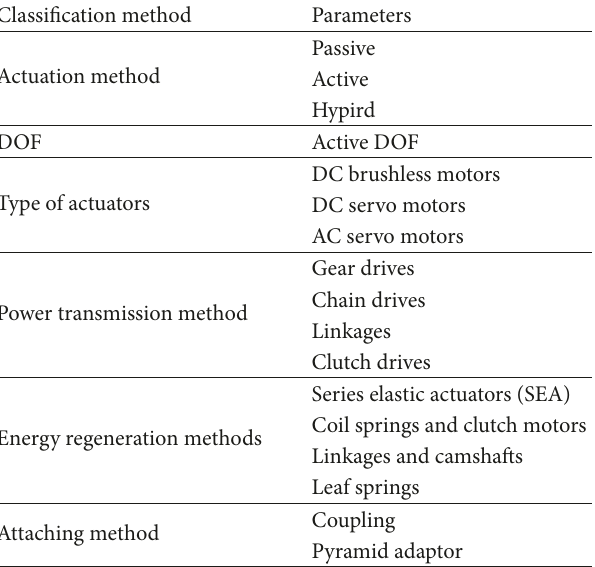
Table 3: Methods of classification of adaptive foot